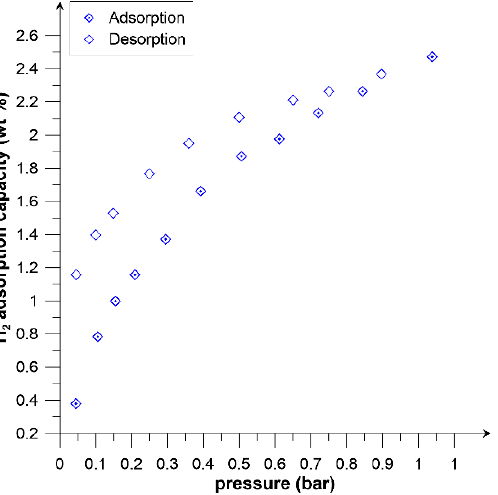
Figure 5. Adsorption/desorption isotherms of hydrogen on Picazine K at 77 K.